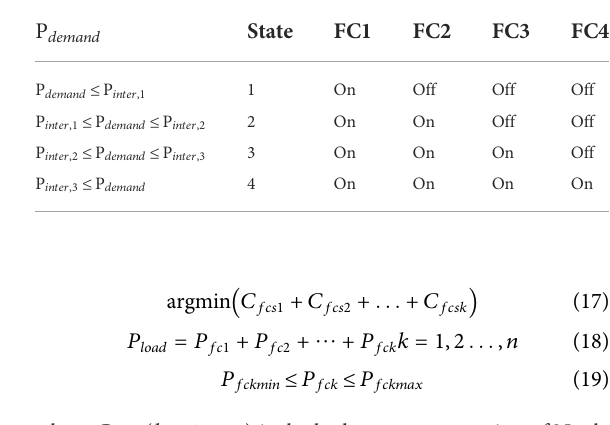
TABLE 2 State machine control